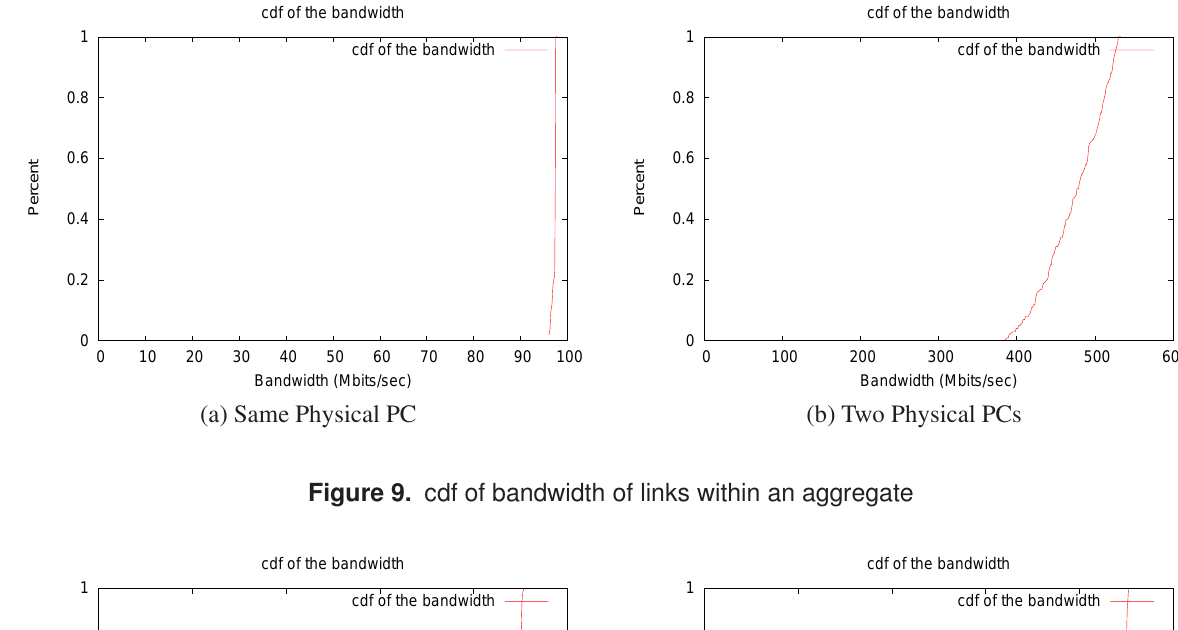
Figure 9. cdf of bandwidth of links within an aggregate